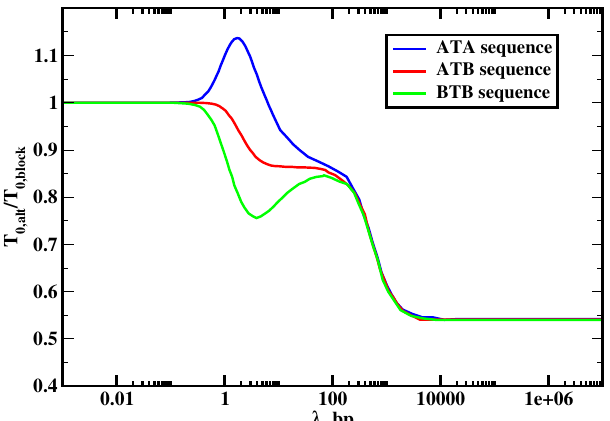
Figure 8. The ratio of the mean search times for the alternating DNA sequences and for the block copolymer DNA sequences as a function of the scanning length λ = compositions near the target (T) are distinguished, namely, ATA , ATB , BTB . The transition rates are u = 10 5 s − 1 and k on = 0.1 s − 1 . The DNA length is L = 1000, the loading parameter is θ = 0.5, and the energy difference of interactions for the protein with A and B sites is ε = 5 k B T. Adapted with permission from Ref.